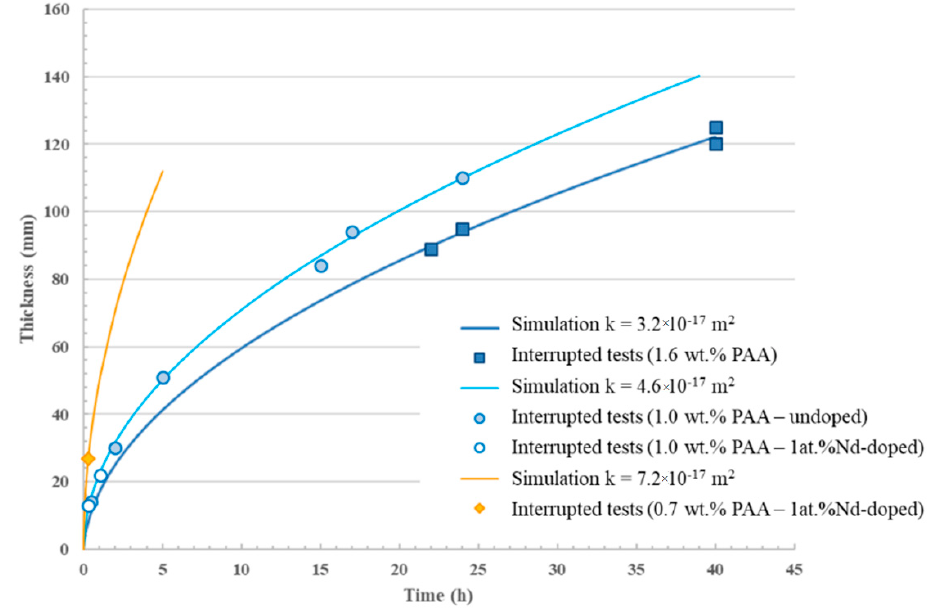
Figure 8. Evolution of cake thickness as a function of time at a pressure filtration of 3 × 10 6 Pa for two different permeabilities showing good agreement between experimental points (stopped tests) and the simulation.